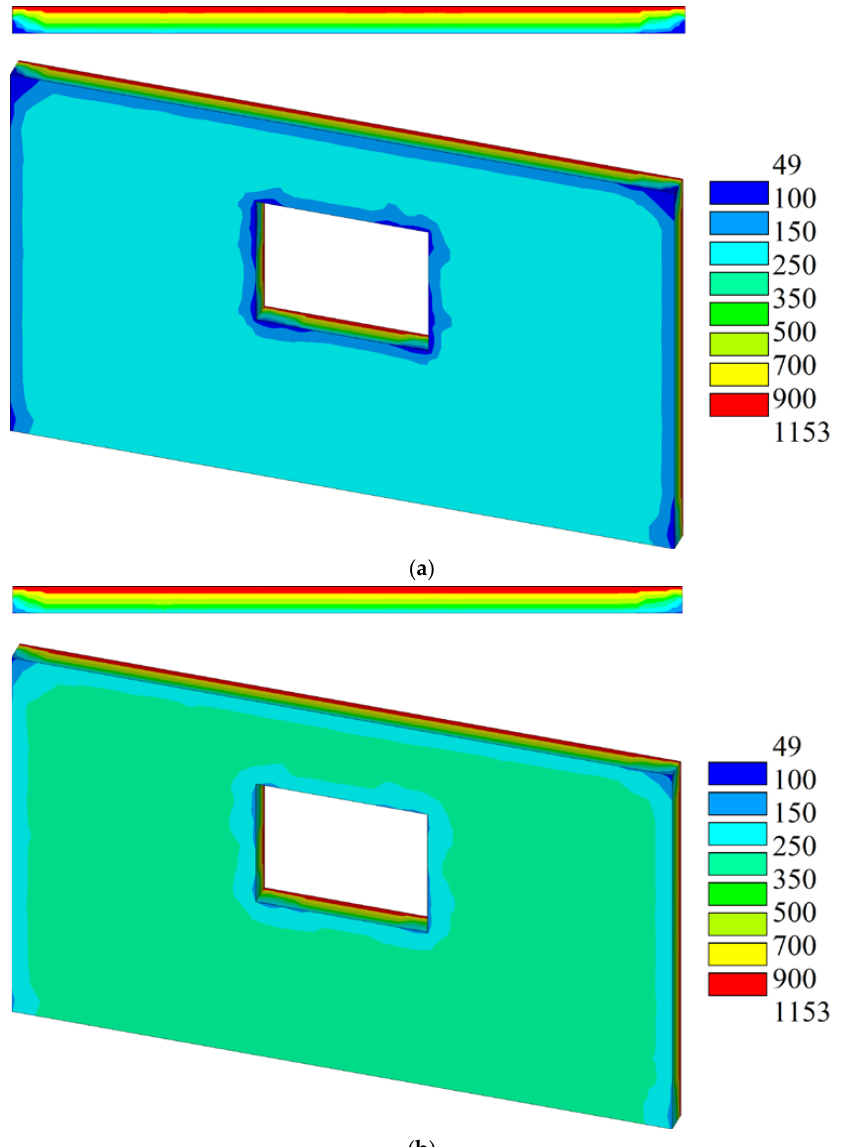
Figure 13. Analysis results for the W1B specimen and two values of material thermal conductivity: ( a ) 0.50 W/m K; ( b ) 1 W/m K.